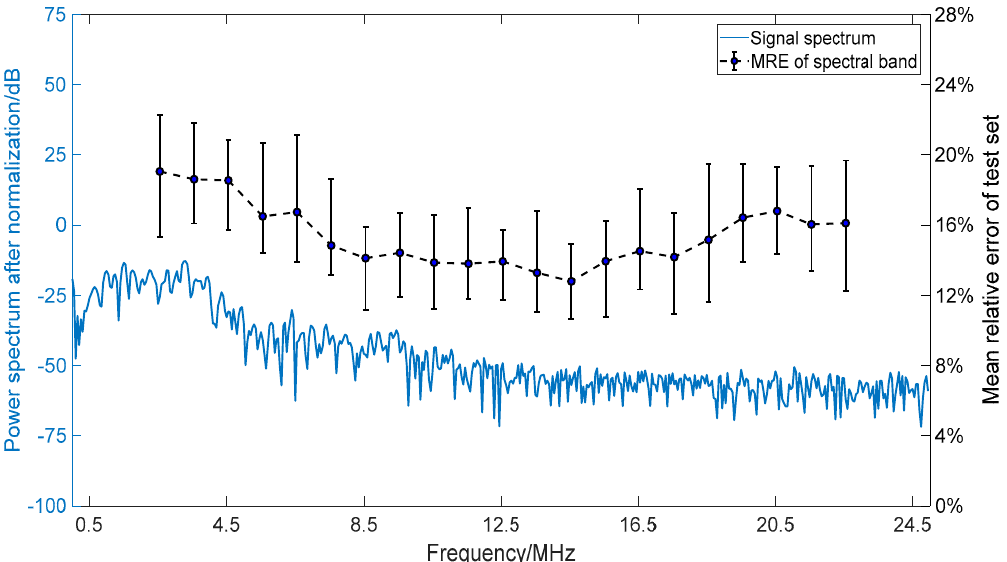
Figure 6. Plot showing mean relative error (MRE) of test set and the corresponding spectral bands. For each spectral band, the minimum, maximum and average of MREs of test set for 10 retrainings are drawn at the center frequency.